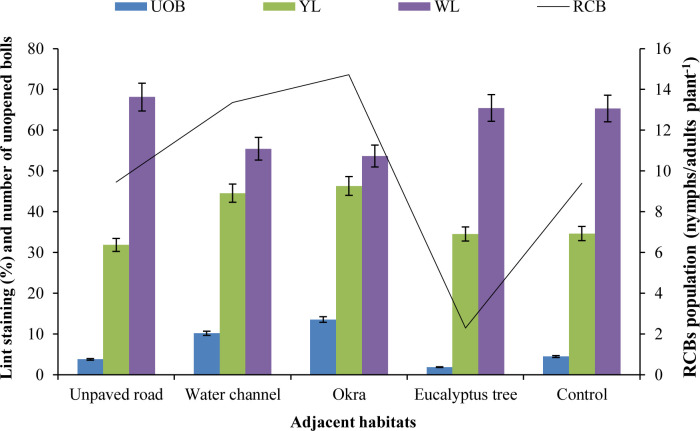
Average population of red cotton bugs and their impact on lint quality during 2012 and 2013.YL = yellowish lint, WL = whitish lint; RCB = red cotton bugs; UOB = unopened bolls.